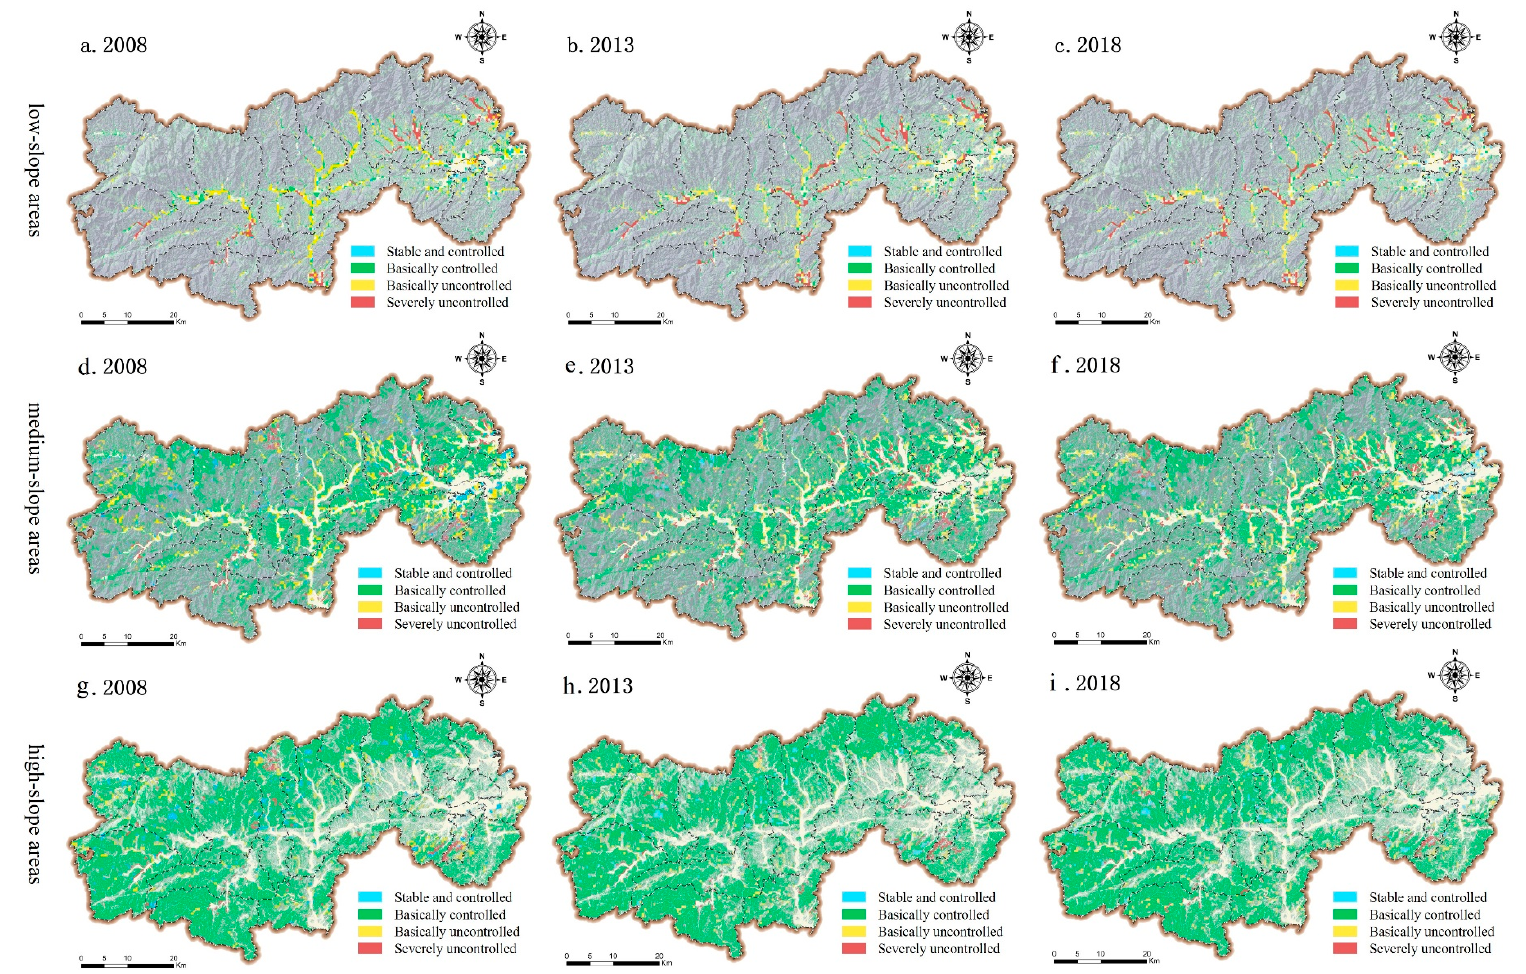
Figure 7. Spatial distribution of potential land-use conflict between agricultural and ecological spaces in low-, medium- and high-slope areas. ( a ) 2008 low-slope areas. ( b ) 2013 low-slope areas. ( c ) 2018 low-slope areas. ( d ) 2008 medium-slope areas. ( e ) 2013 medium-slope areas. ( f ) 2018 medium-slope areas. ( g ) 2008 high-slope areas. ( h ) 2013 high-slope areas. ( i ) 2018 high-slope areas.